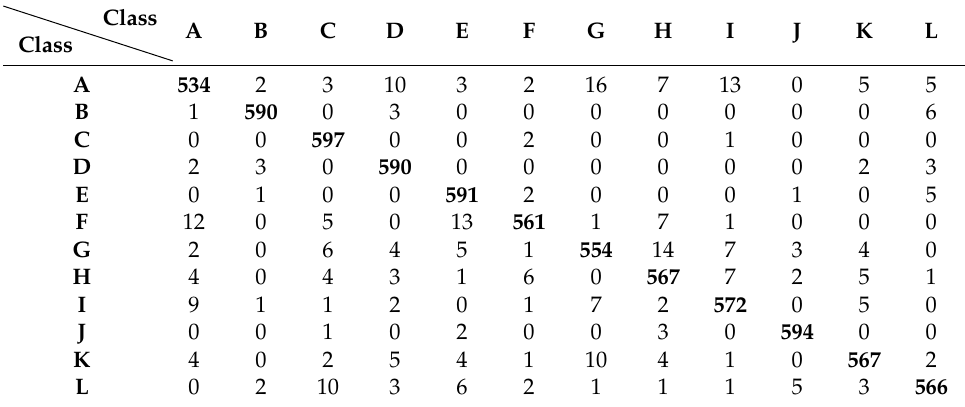
Table 4. Classification results after combination using Majority voting procedure.